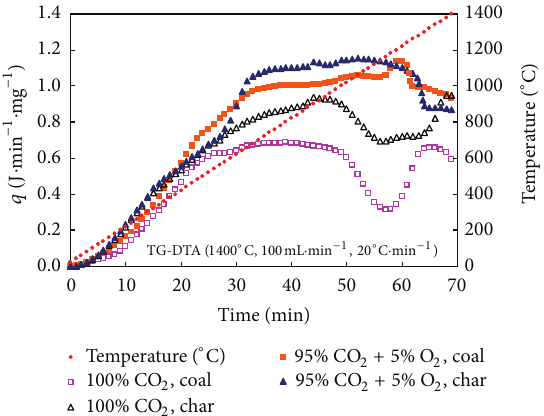
Figure 21: HCs gas generation from coal in air and CO 2 -rich gas